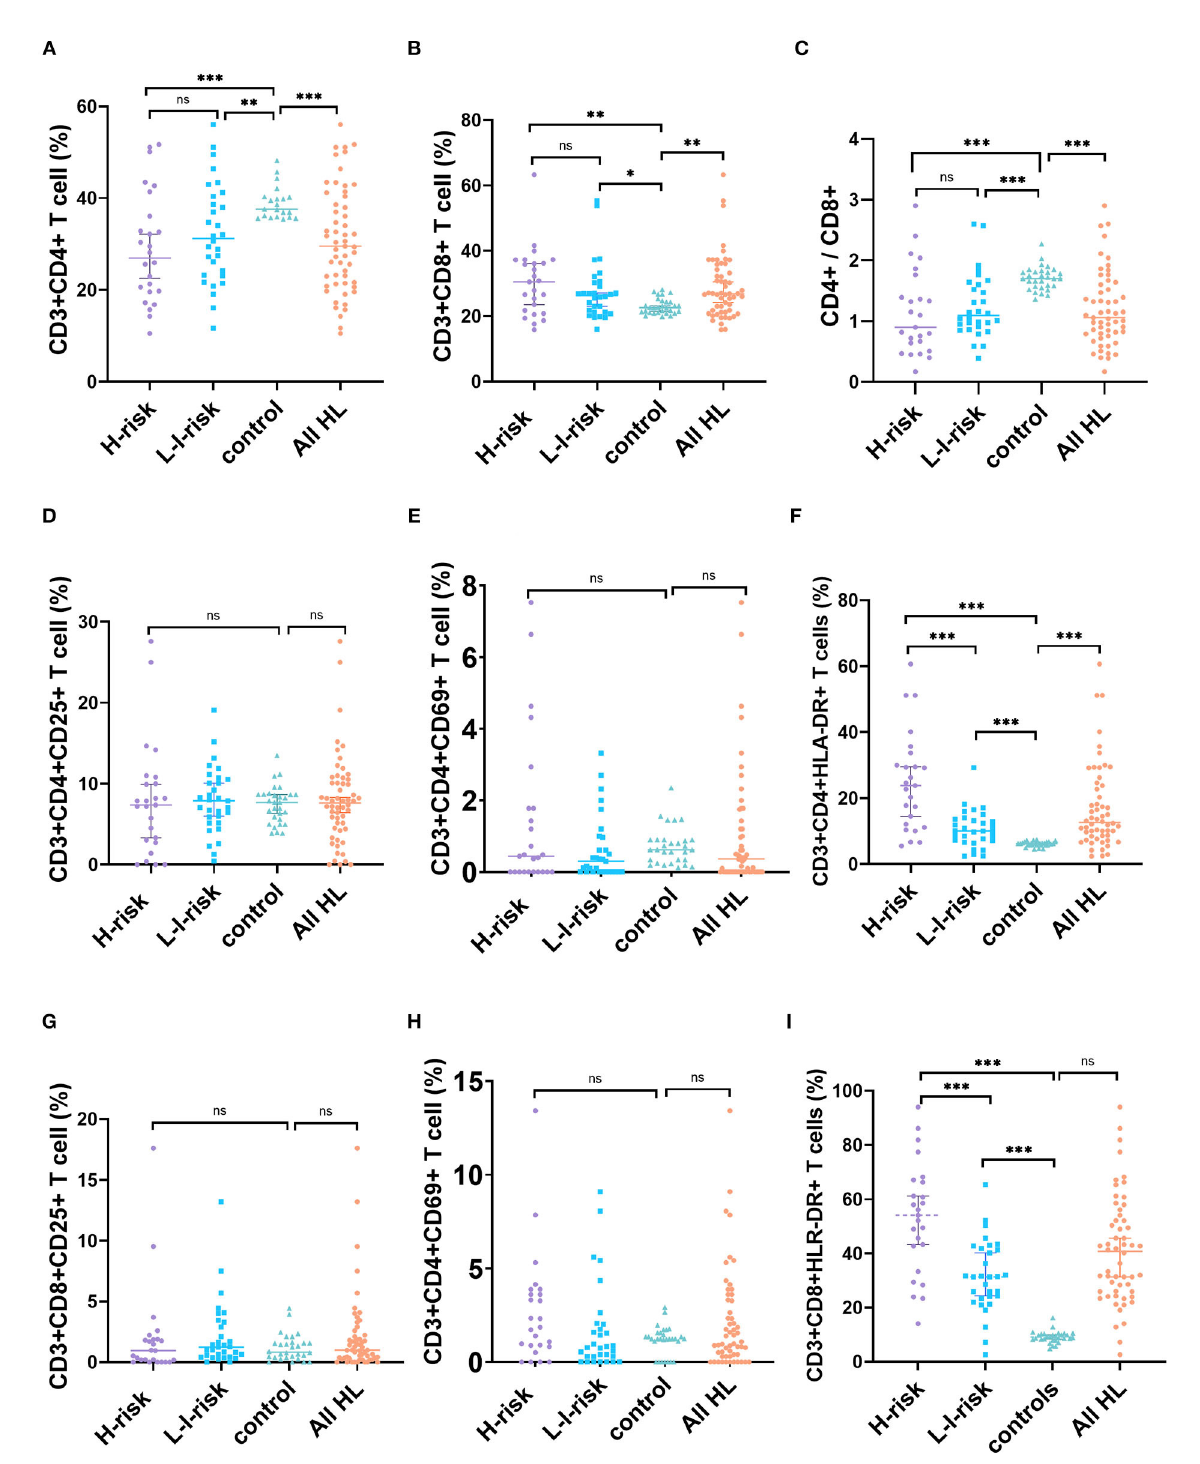
FIGURE2 Changes in percentages of T-cell subset markers in patients with HL and health controls. (A) CD4 + T cells, (B) CD8 + T cells, (C) CD4 + /CD8 + ratio, (D) CD3 + CD4 + CD25 + T cells, (E) CD3 + CD4 + CD69 + T cells, (F) CD3 + CD4 + HLA-DR + T cells, (G) CD3 + CD8 + CD25 + T cells, (H) CD3 + CD8 + CD69 + T cells, and (I) CD3 + CD8 + HLA-DR + T cells. ns, not significant, p > 0.05; * p < 0.05, ** p < 0.01; *** p <